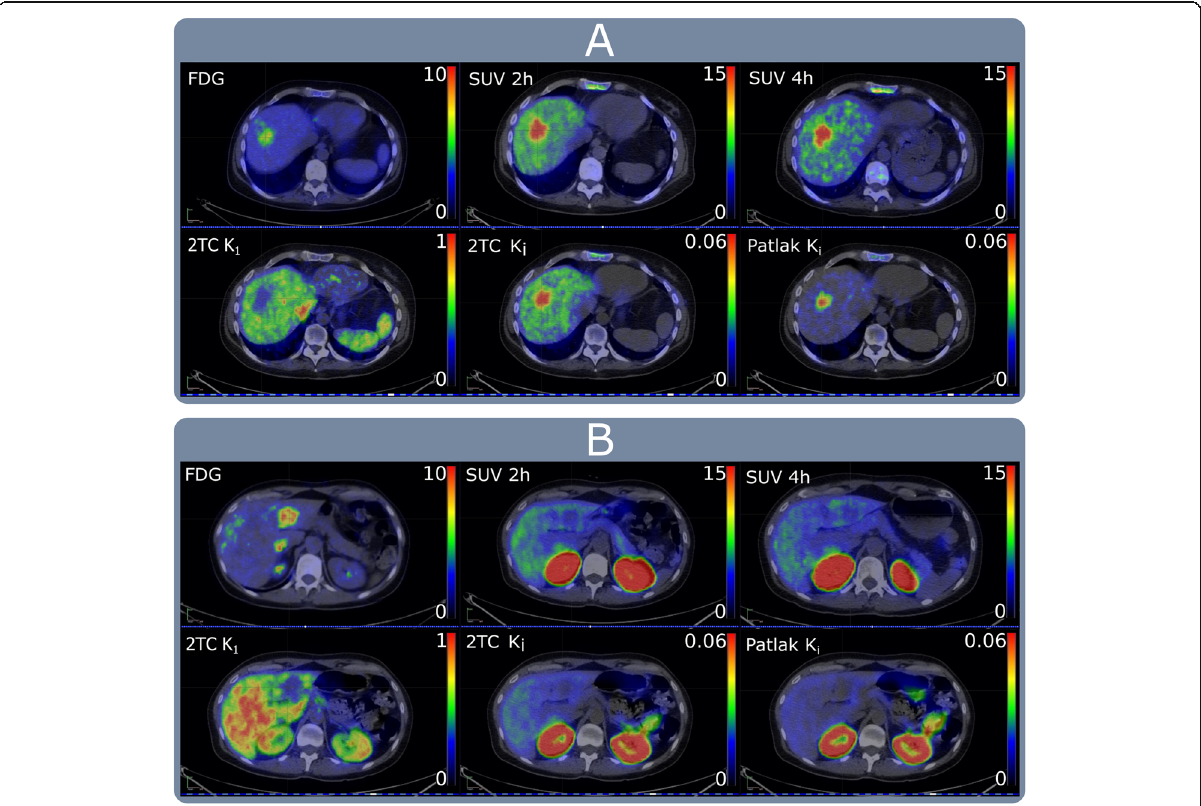
Fig. 4 Positron emission tomography (PET) images. a In a patient with HER2-positive expression. b In a patient with HER2-negative expression. 18 F-FDG PET images to the left followed by SUV static image taken at 2 h time point after 68 Ga-ABY-025 injection. 2TC K i , Patlak K i , and (2TC) K are parametric images created from the 68 Ga-ABY-025 dynamic PET study ( K 1 , transfer rate constant from plasma to the tissue compartment; K i , influx rate of the tracer into irreversible compartment)